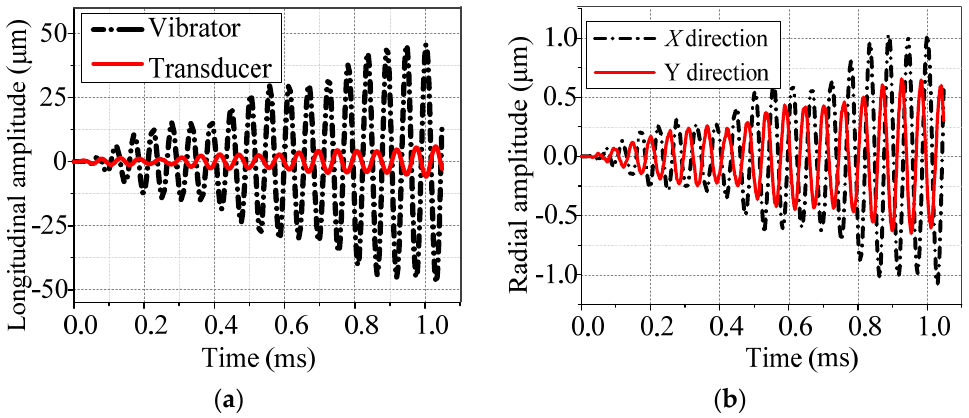
Figure 10. Transient analysis of the power-superimposing vibration system driving by sinusoidal voltages with a phase difference of 120° between each other. ( a ) Longitudinal amplitude of vibrator and transducers. ( b ) Radial amplitude in X and Y directions.